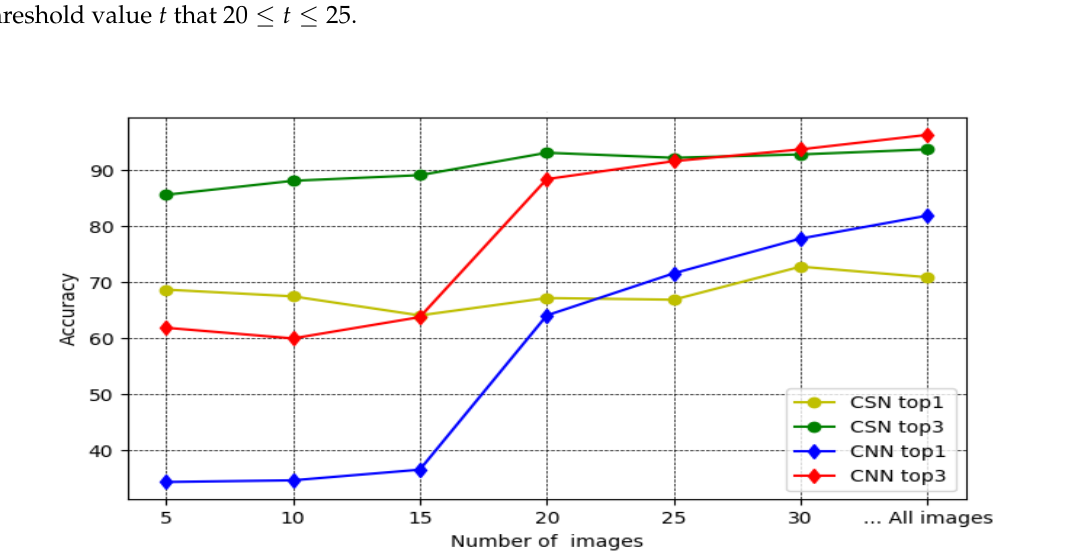
Figure 9. Top-1 and top-3 accuracy for the CSN and